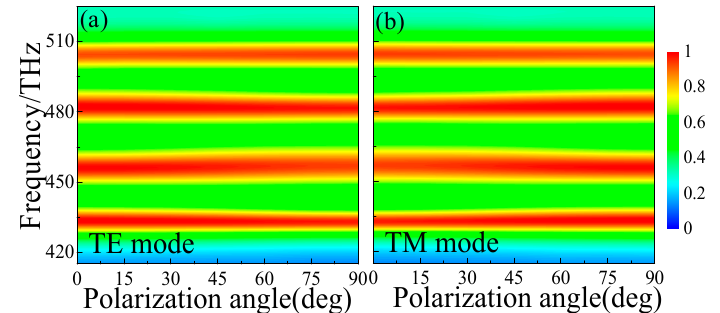
Figure 5 . Simulated absorbance under normal incidence with different polarization angles at for ( a ) transverse electric (TE) and ( b ) transverse magnetic (TM) modes.